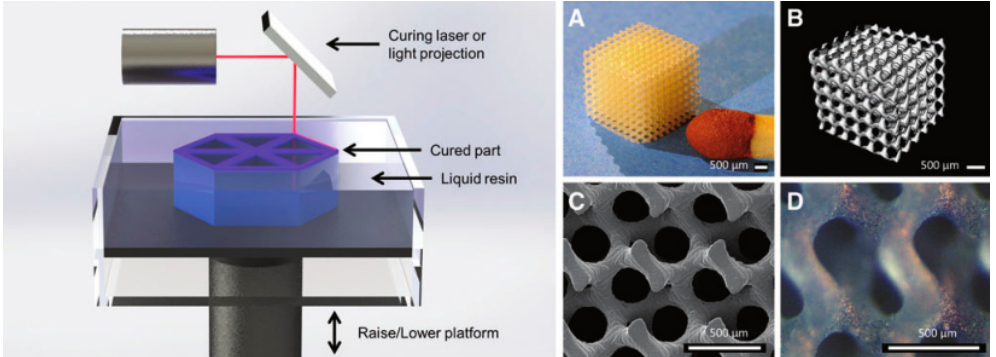
Figure 4. Schematic of stereolithographic (SLA) printing technique; and ( A – D ) exemplary tissue engineering scaffold composed of poly( D - L lactic acid) (PDLLA) that showcases the resolution and detail of SLA [46]: ( A ) photograph; ( B ) micro computed tomography (mCT); and ( C , D ) scanning electron microscope (SEM). Scale bar is 500 mm.